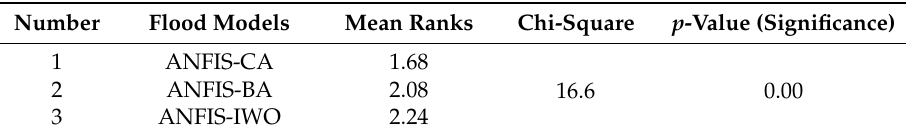
Figure 14. Percentages of different flood susceptibility classes in the Haraz watershed. Table 2. Freidman test achievement